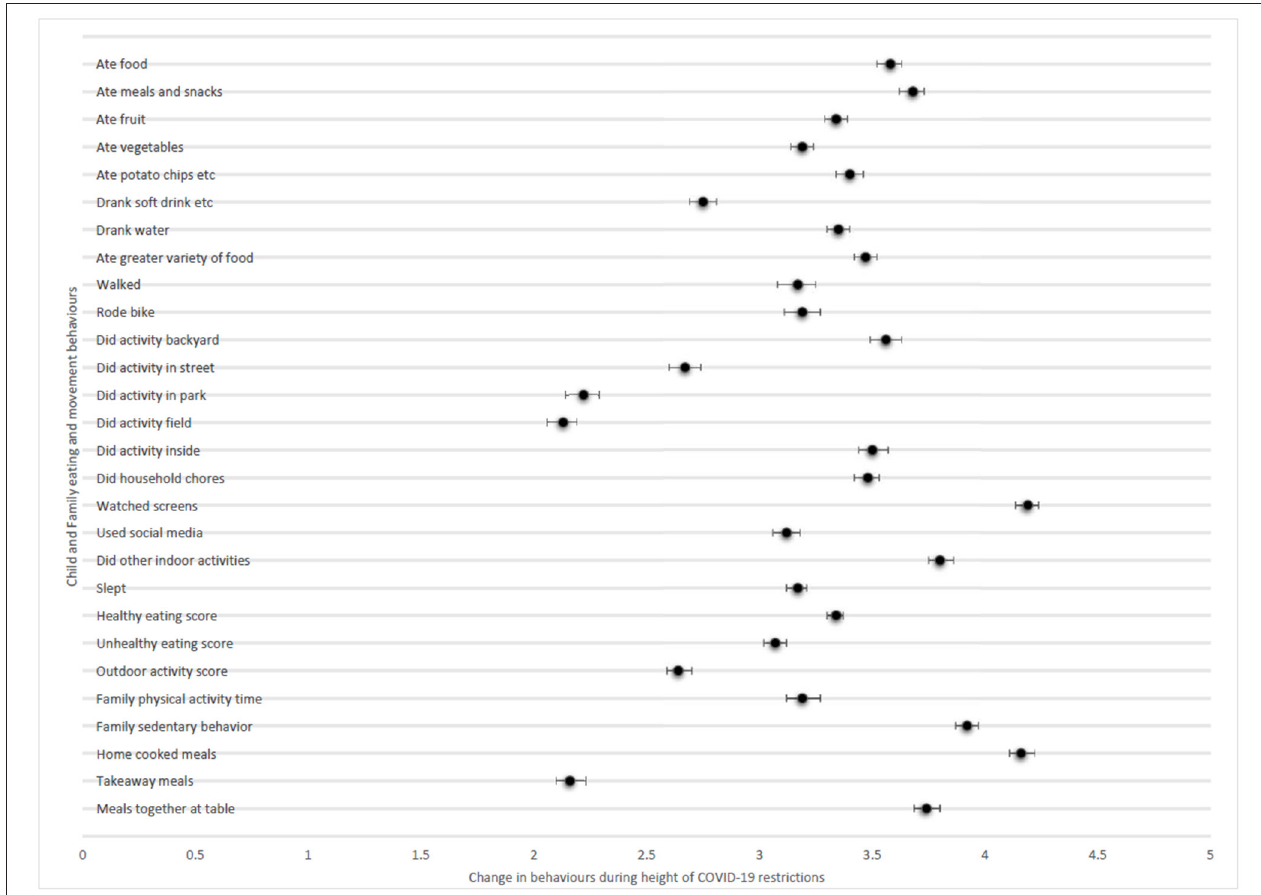
FIGURE 1 | Parent-reported changes in child and family eating and movement behaviors (attached file). Child and family movement behaviors and family eating behaviors: A lot less = 1, a lot more = 5. Child eating behaviors: Totally disagree = 1, totally agree =